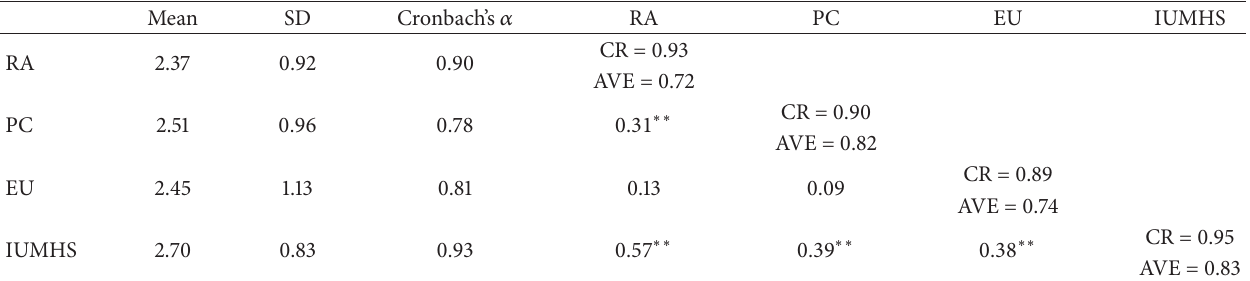
Table 5: Descriptive statistics, correlations, and reliability.